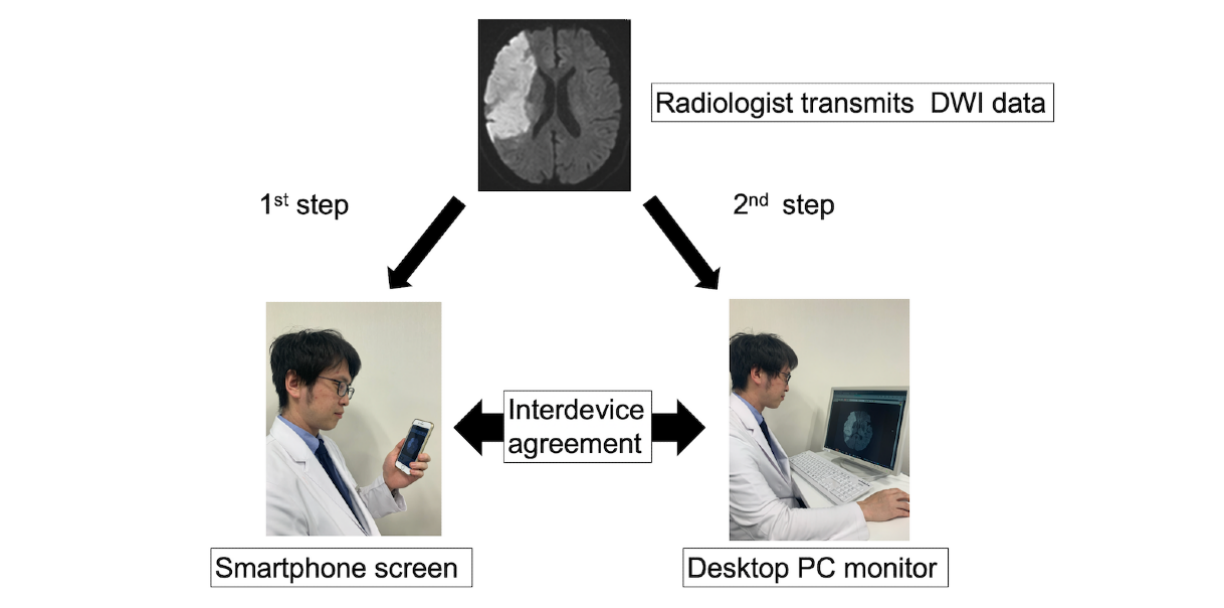
Figure 2. Study protocol. First, the vascular neurologists evaluated DWI-ASPECTS on a smartphone screen. Second, they evaluated DWI-ASPECTS on a desktop PC monitor. Interdevice agreement and interrater agreement were calculated for the same and for different devices. DWI-ASPECTS: Diffusion-Weighted Imaging–Alberta Stroke Program Early Computed Tomography